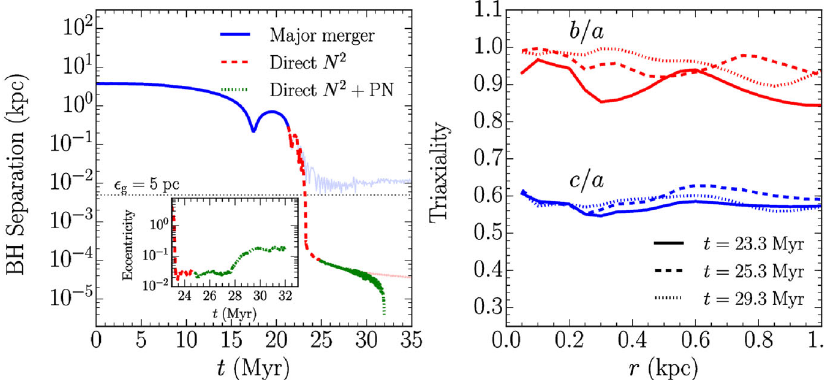
Fig. 20 Evolution of an MBH pair in direct N -body simulations of a galaxy merger (obtained from cosmological simulations) at redshift z (cid:1) 3. Left: MBH separation as a function of time; the small plot shows the time evolution of the Keplerian eccentricity past the binary formation. Right: Merger remnant axis ratios as a function of the radius for different simulation times. Figure adapted from Khan et al.